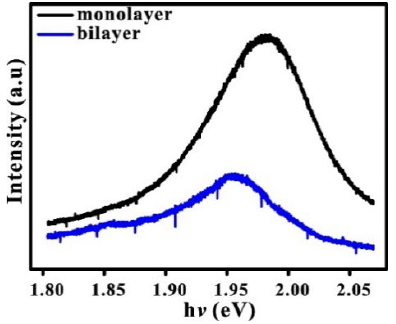
Figure 3. Photoluminescence spectra of WS 2 monolayer and bilayer .